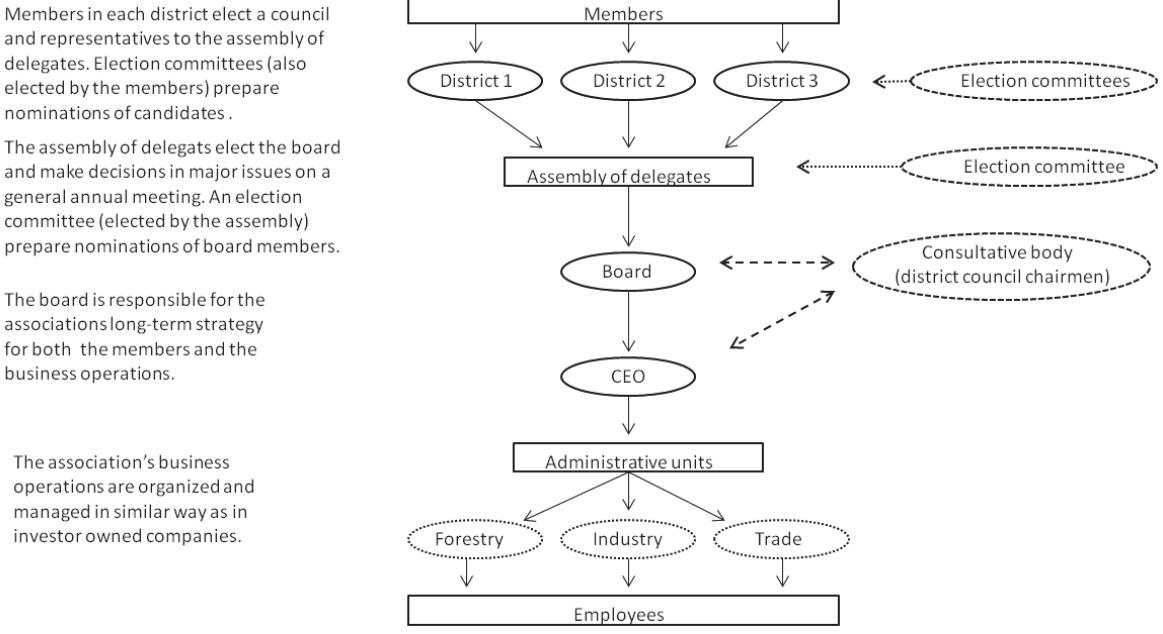
Figure 1. The organization and governance structure of forest owners’ associations in